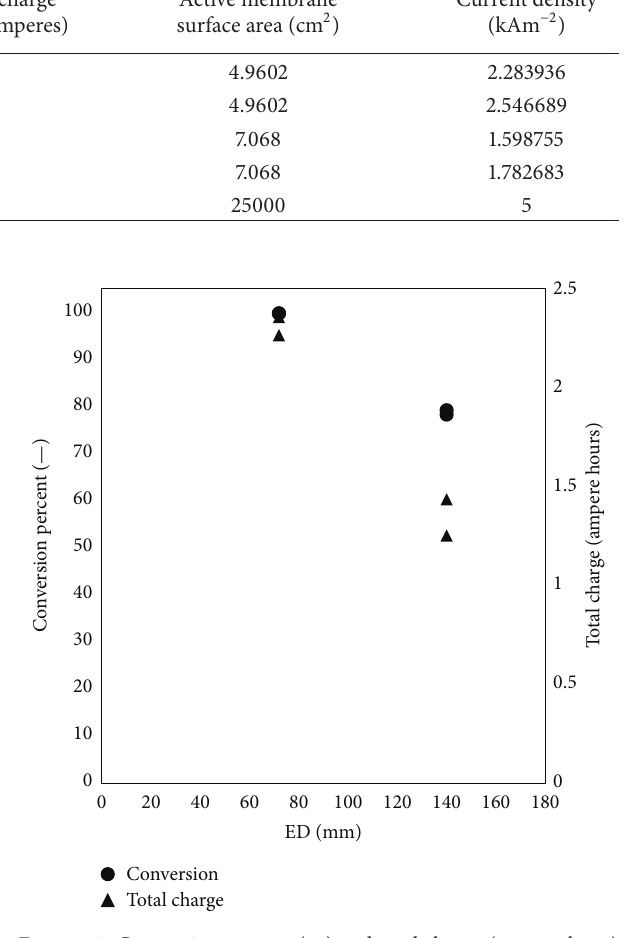
Figure 11: Conversion percent (—) and total charge (ampere hour) versus ED (mm) for 2N feed